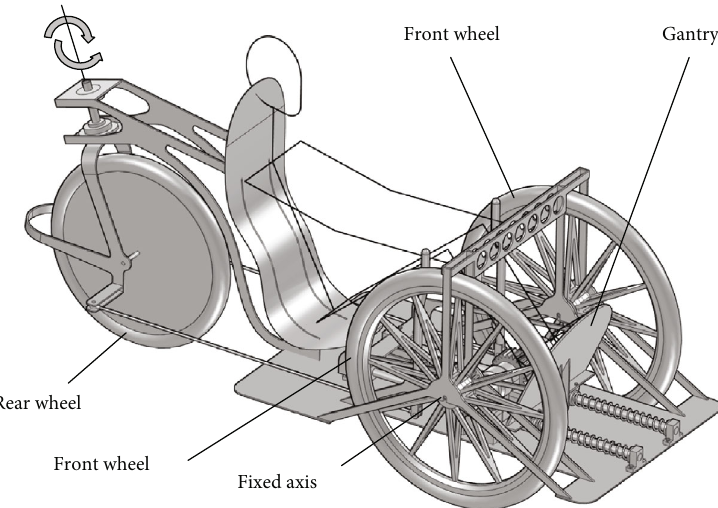
Figure 1: The gantry used in the horizontal bike.